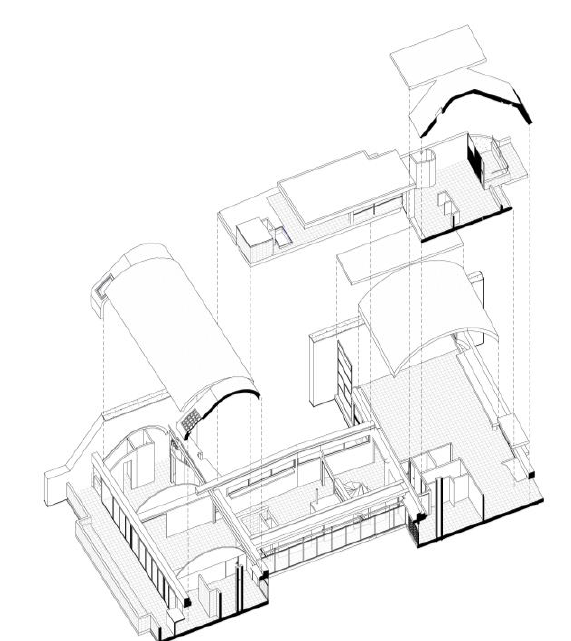
Figure 15. 3D model used to explain the different part of the apartment